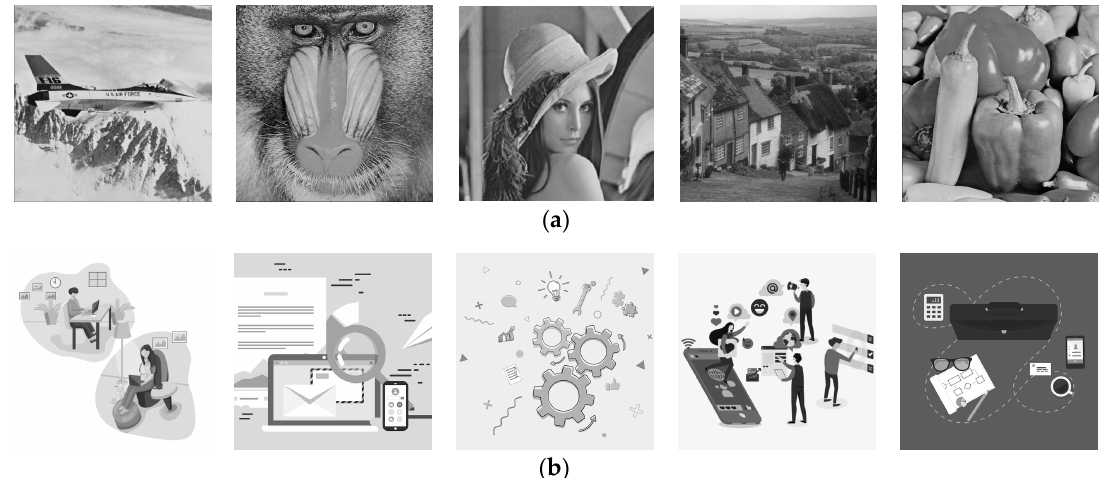
Figure 7. Cover images: ( a ) from the USC-SIPI database; ( b ) from pixabay.com.